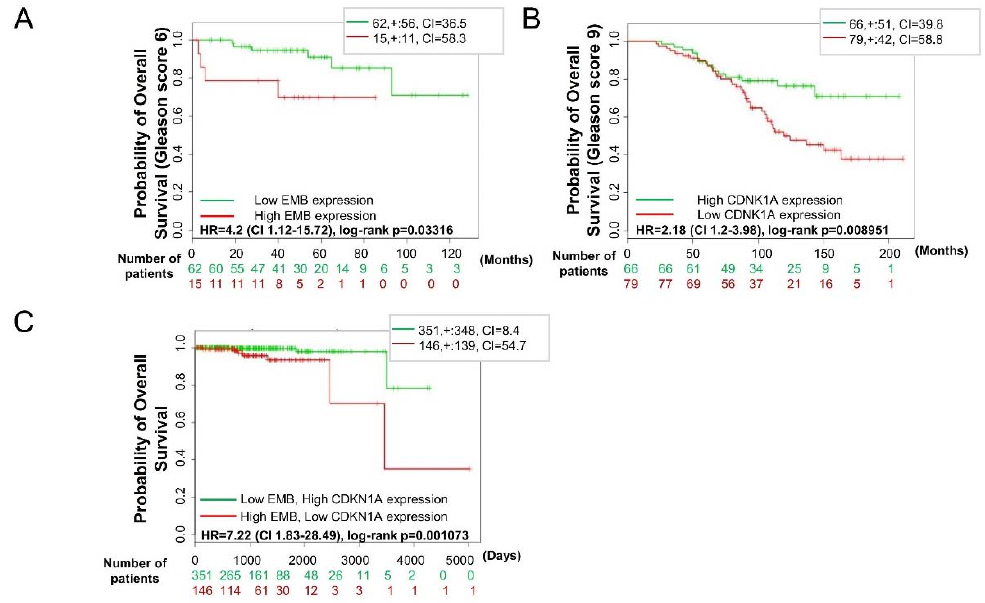
Figure 8. Embigin and p21 (CDKN1A) expression in prostate cancer tissue can predict survival. ( A ) Overall survival determined by Kaplan-Meier analysis of prostate cancer patients with either high or low EMB mRNA expression, ( B ) high or low p21 (CDNK1A) mRNA expression, and ( C ) high EMB and low p21 (CDNK1A) mRNA expression or low EMB and high p21 (CDNK1A) mRNA expression.